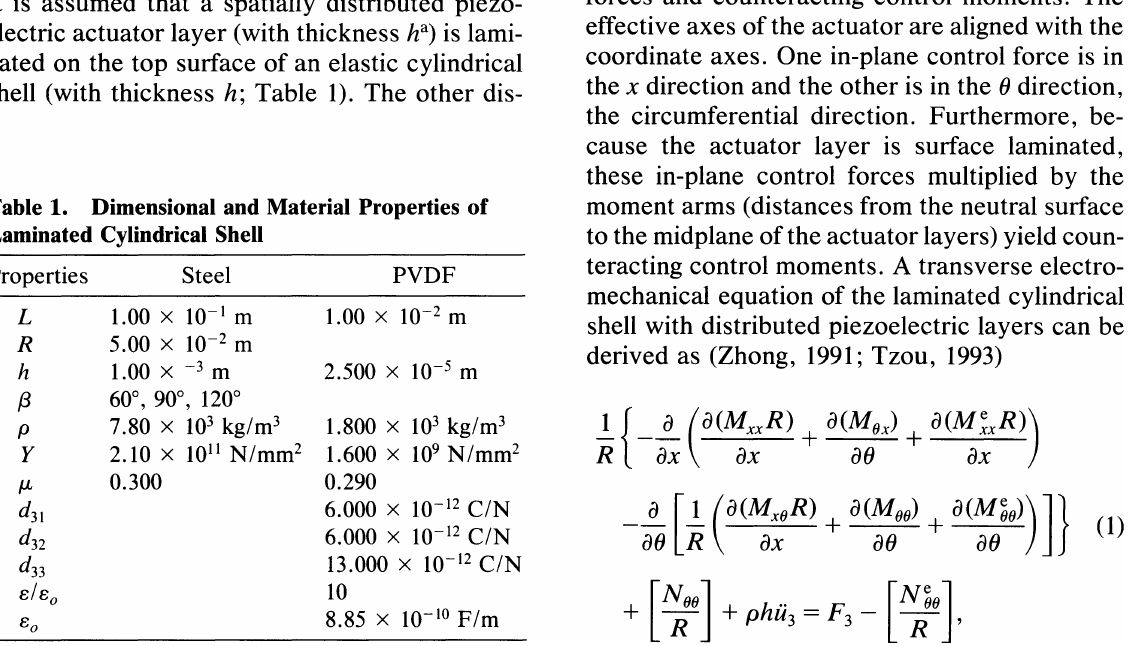
Laminated Cylindrical Shell